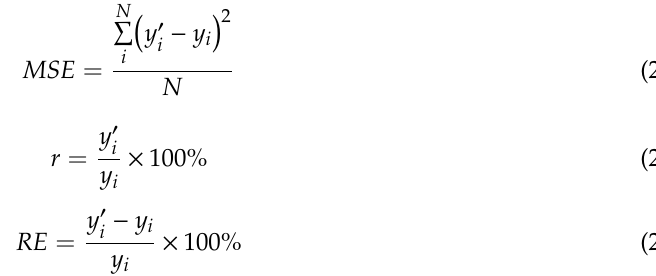
Figure 3. The filter system uses slits, a collimator, a grating, a focus lens, and plane mirrors to obtain the necessary experimental monochrome. The chamber consists of two parts: reference chamber I and test chamber II. The length of chambers is 0.9 m. Reference chamber I is filled with nitrogen, and the test chamber Ⅱ is filled with the target gas (methane). As shown in Figure 2, the e ff ective optical path can be extended to 2.7 m because the light was reflected twice in chamber. Light from the light source is scattered in the air inlet of the chamber, therefore, a graduated refractive index (GRIN) rod lens is placed at the inlet and outlet of the chamber. The pigtail of the GRIN rod lens is fused with transmission optical